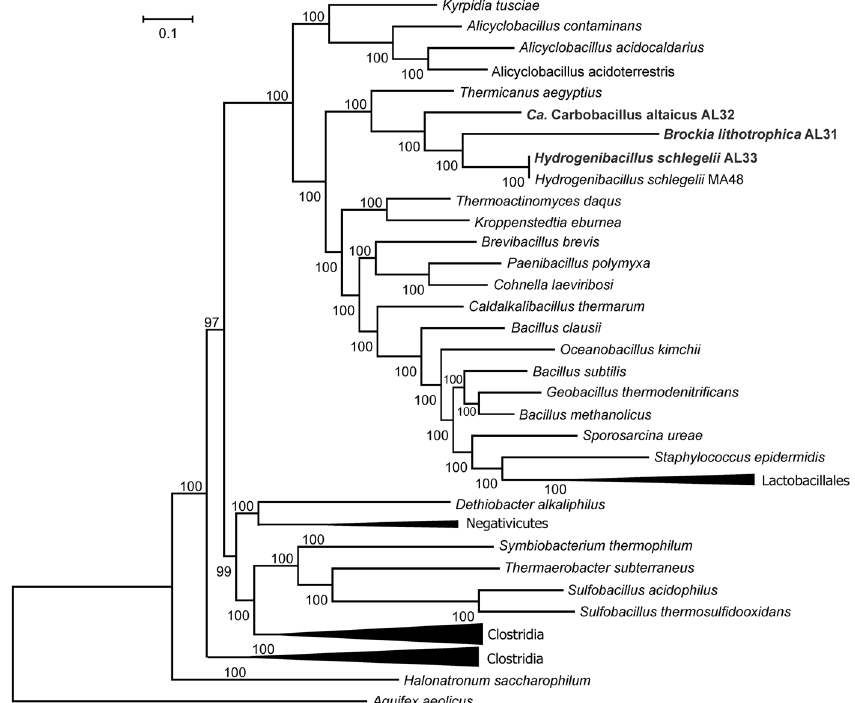
Figure 4. Position of the new genomes in the maximum likelihood concatenated protein phylogeny. The tree was inferred from the concatenation of 43 conserved marker genes and incorporates 59 genomes and 3 new genome bins. The support values for the internal nodes were estimated by approximate Bayes tests in PhyML. The scale bar represents the average number of substitutions per